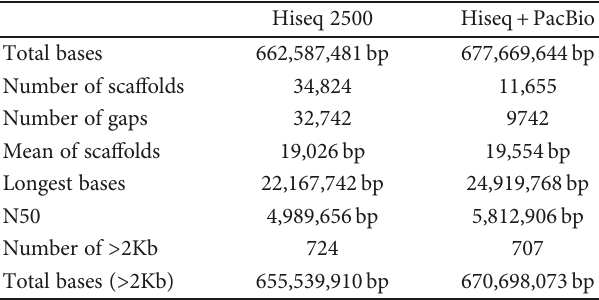
Table 1: Summary statistics of the whole-genome sequence assembly of greater